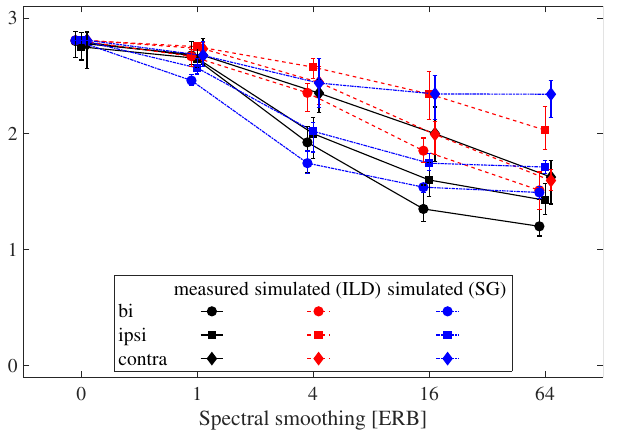
Figure 9. Median values of simulated externalization ratings with (dashed lines, “ c < 1 ” ) and without (dash-dotted lines, “ c = 1 ” ) the reduction term in the model for different spectral smoothing ( “ B ” ) and reverberation compression levels. All other conventions are as in Figure 2.